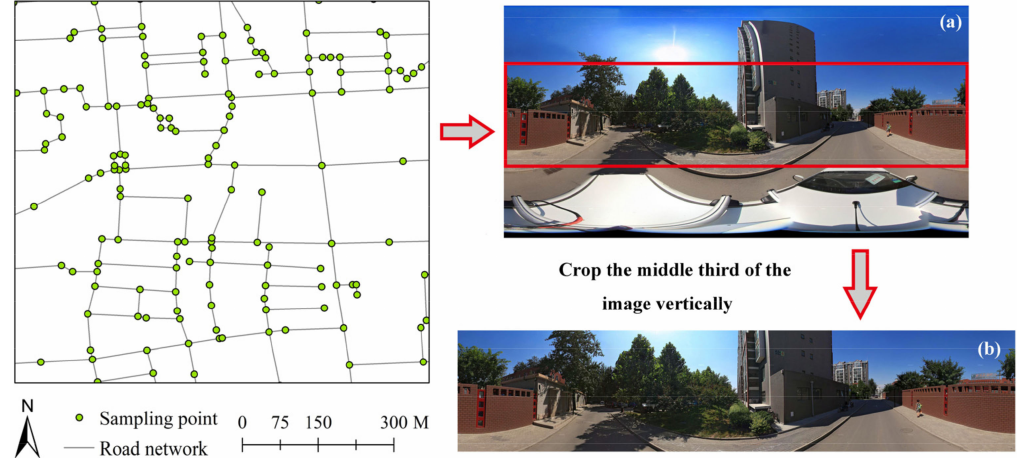
Figure 3. ( a ) Original street view images (SVIs) (panorama), ( b ) cropped